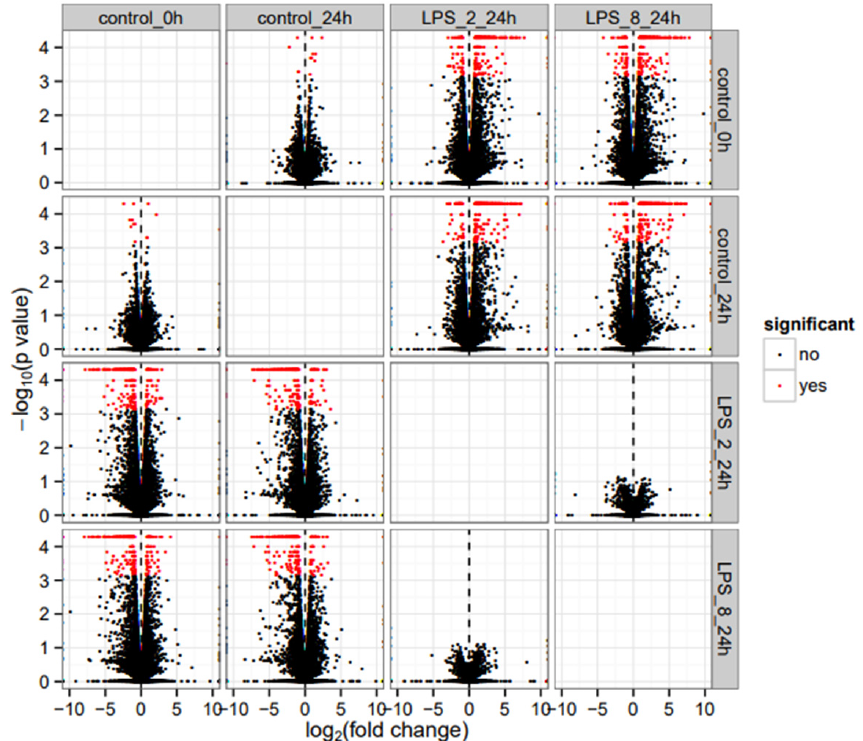
Figure 1. Comparison between different groups following LPS challenge including Control 0 h, Control 24 h, LPS-2 μ g/mL 24 h, and LPS-8 μ g/mL 24 h. Dots in red show DEGs (adjusted p value < 0.05 from Benjamini-Hochberg correction). Significant means positive log2 fold changes correspond to increased expression, whereas negative values correspond to decreased expression.